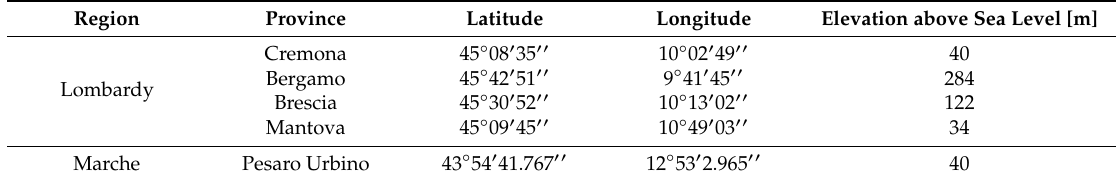
Table 2. Location of the monitoring stations in northwest and central